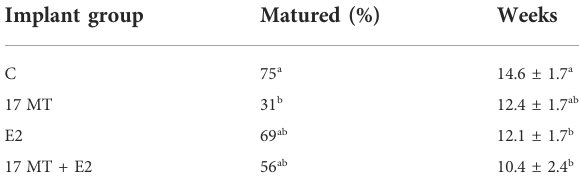
TABLE 3 Effects of carp pituitary extract treatment (CPE) on eels from the different treatment groups with C = control with sham implant; 17 MT = 17 α methyltestosterone implant; E2 = 17 β -estradiol implant, and 17 MT + E2 = the co-implantation. % matured indicates the percentage of eels that reached full sexual maturation (hydrationresponseandoocytematurationasindicatedbyabody weight index of > 110) and the number of weeks with weekly CPE injections that the eels needed to reach this stage. Statistical differences between groups which are indicated by letters